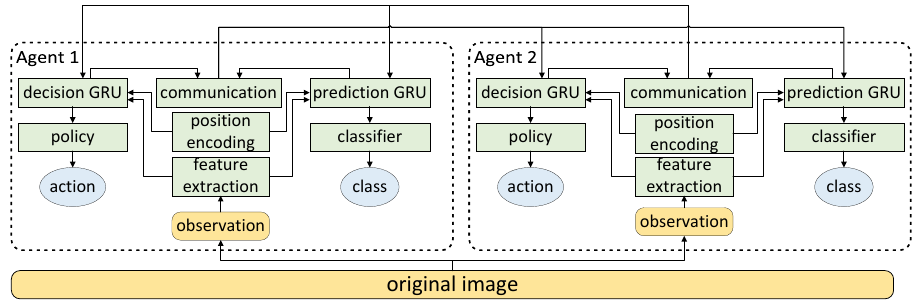
Figure 2. The overall network structure.